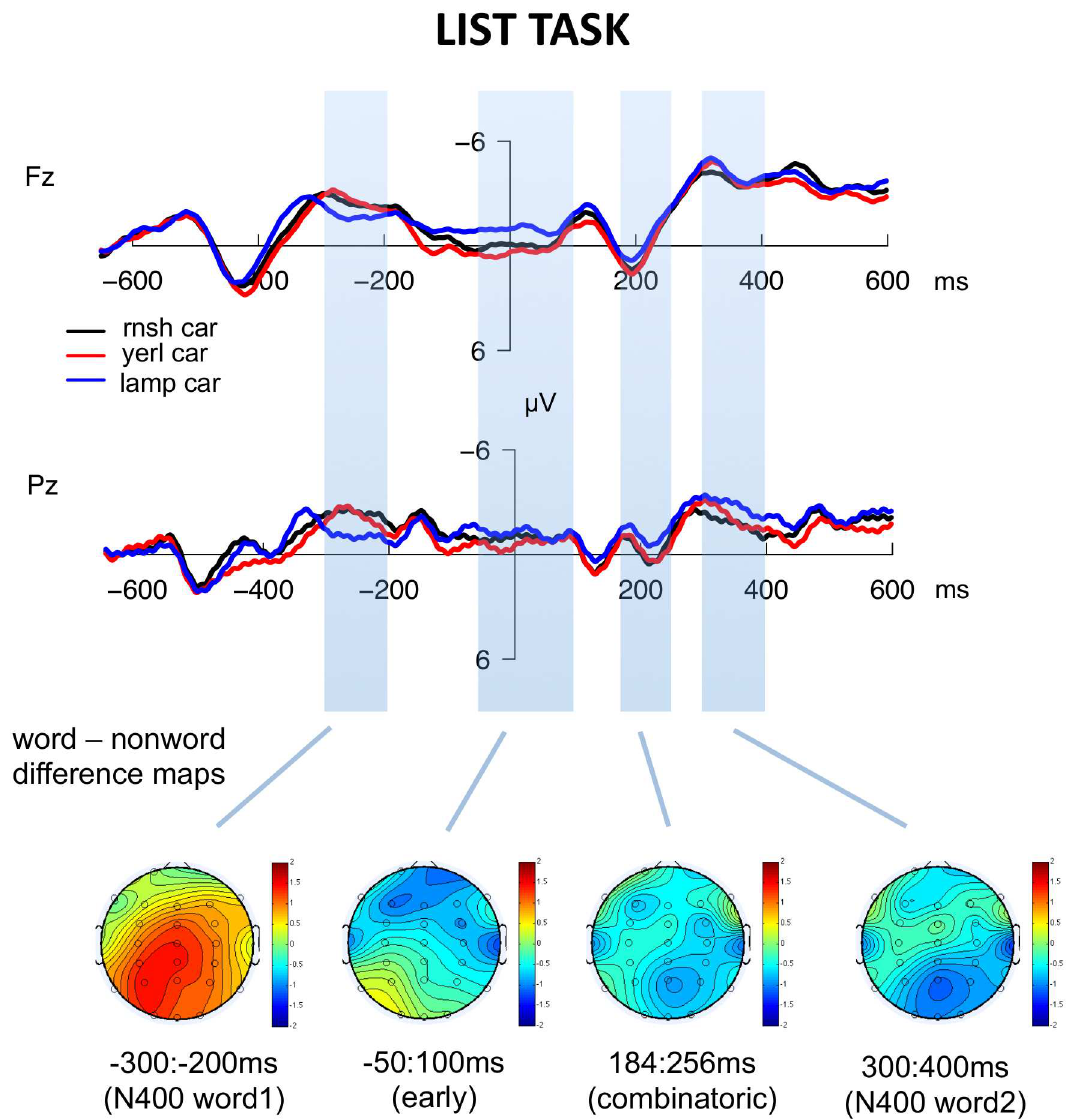
Fig 4. ERP waveforms and topographical distributions for the three conditions in the list task. Waveforms illustrate the responsesat representative electrodesFz and Pz. Scalp maps illustrate the estimated activity resulting from the subtraction real word—nonword ( lamp car — rnsh car ) averaged across the time-window indicated.